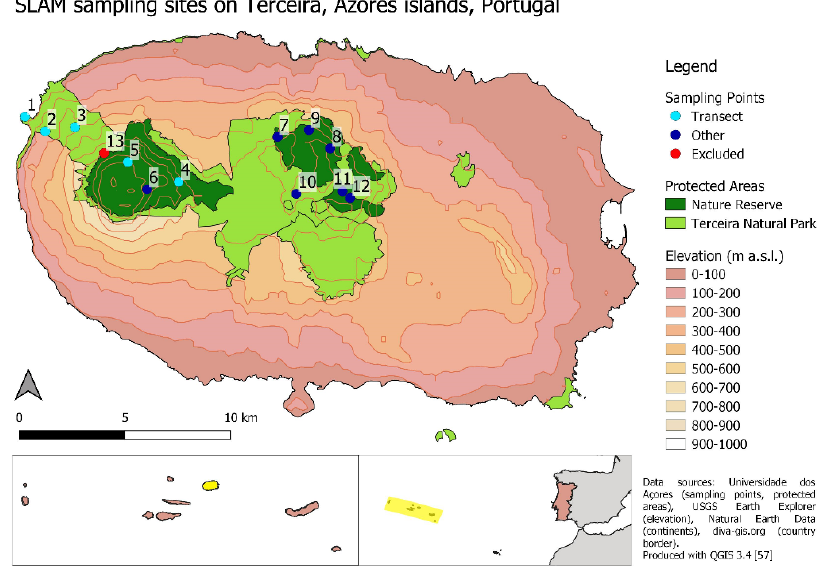
Figure 1. Map of Terceira island, showing the island’s elevation above sea level and the location of protected areas that represent the remaining distribution of semi-natural vegetation (Terceira Natural Park) and native laurel forests (Nature Reserve) [57]. The 12 SLAM sampling sites analysed in this study are indicated in light blue (transect sites representing the elevation gradient at 46 m (1), 231 m (2), 404 m (3), 693 m (4) and 930 m (5) a.s.l.) and dark blue (other sites). One site was excluded due to persisting field problems (red). The two insets at the bottom indicate the location of Terceira island within the Azores archipelago ( left ) and the location of the Azores in the Atlantic ocean west of Portugal ( right